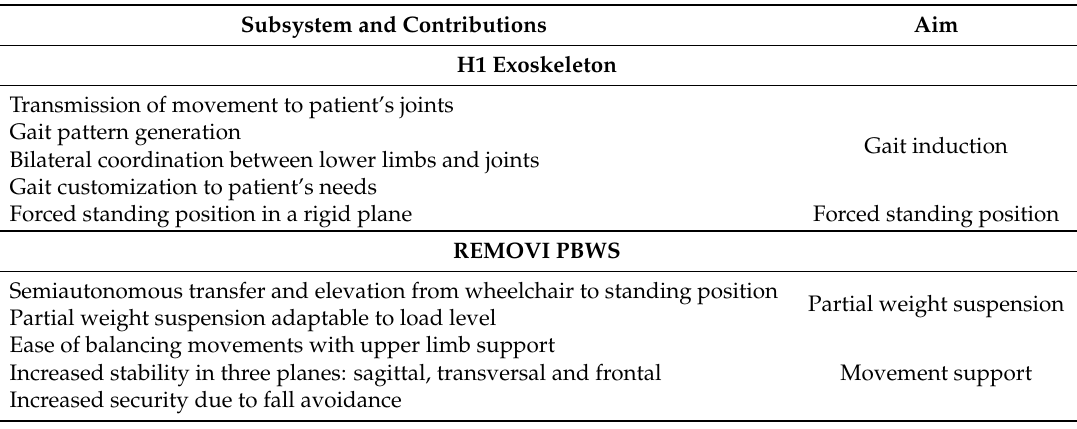
Table 12. HYBRID system’s main